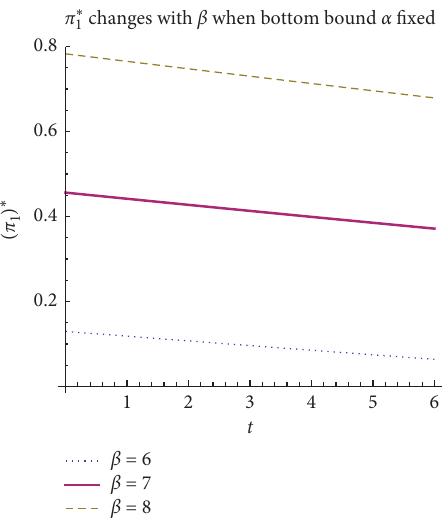
change with t for different current asset- 1